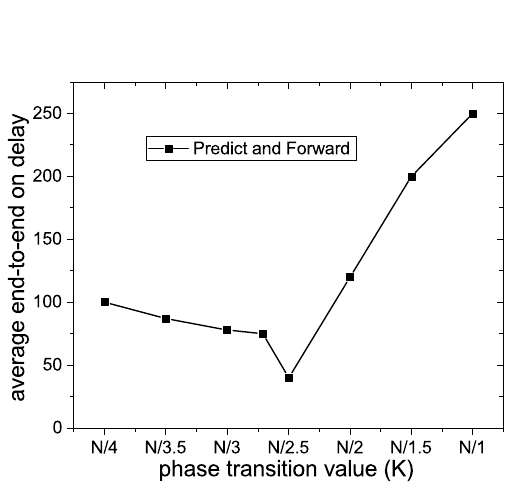
Figure 8. Overhead.